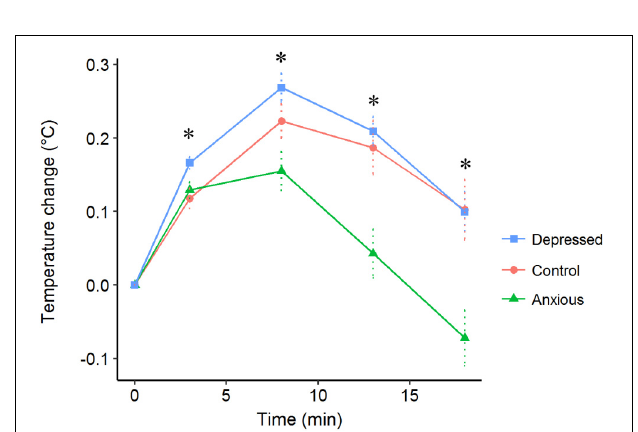
FIGURE 6 | Mean ( ± SE) change in body temperatures after beginning attention bias testing (Time 0) for the Control ( • ), Depressed ( (cid:4) ), and Anxious ( (cid:78) ) groups. Sheep completed the attention bias test after 3 min. The “ ∗ ” symbol denotes a significant difference between treatment groups as determined using a repeated measures linear mixed model and post hoc